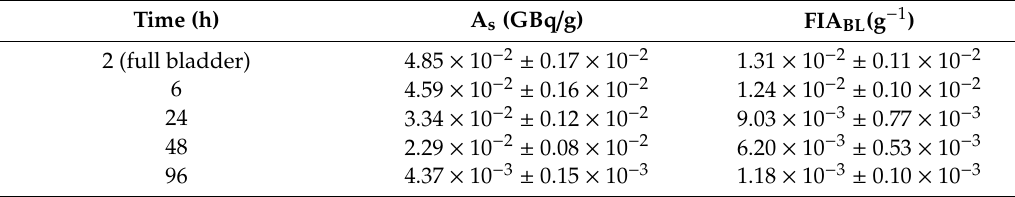
Table 2. Blood (BL) specific activity per gram and calculated FIA values. Time